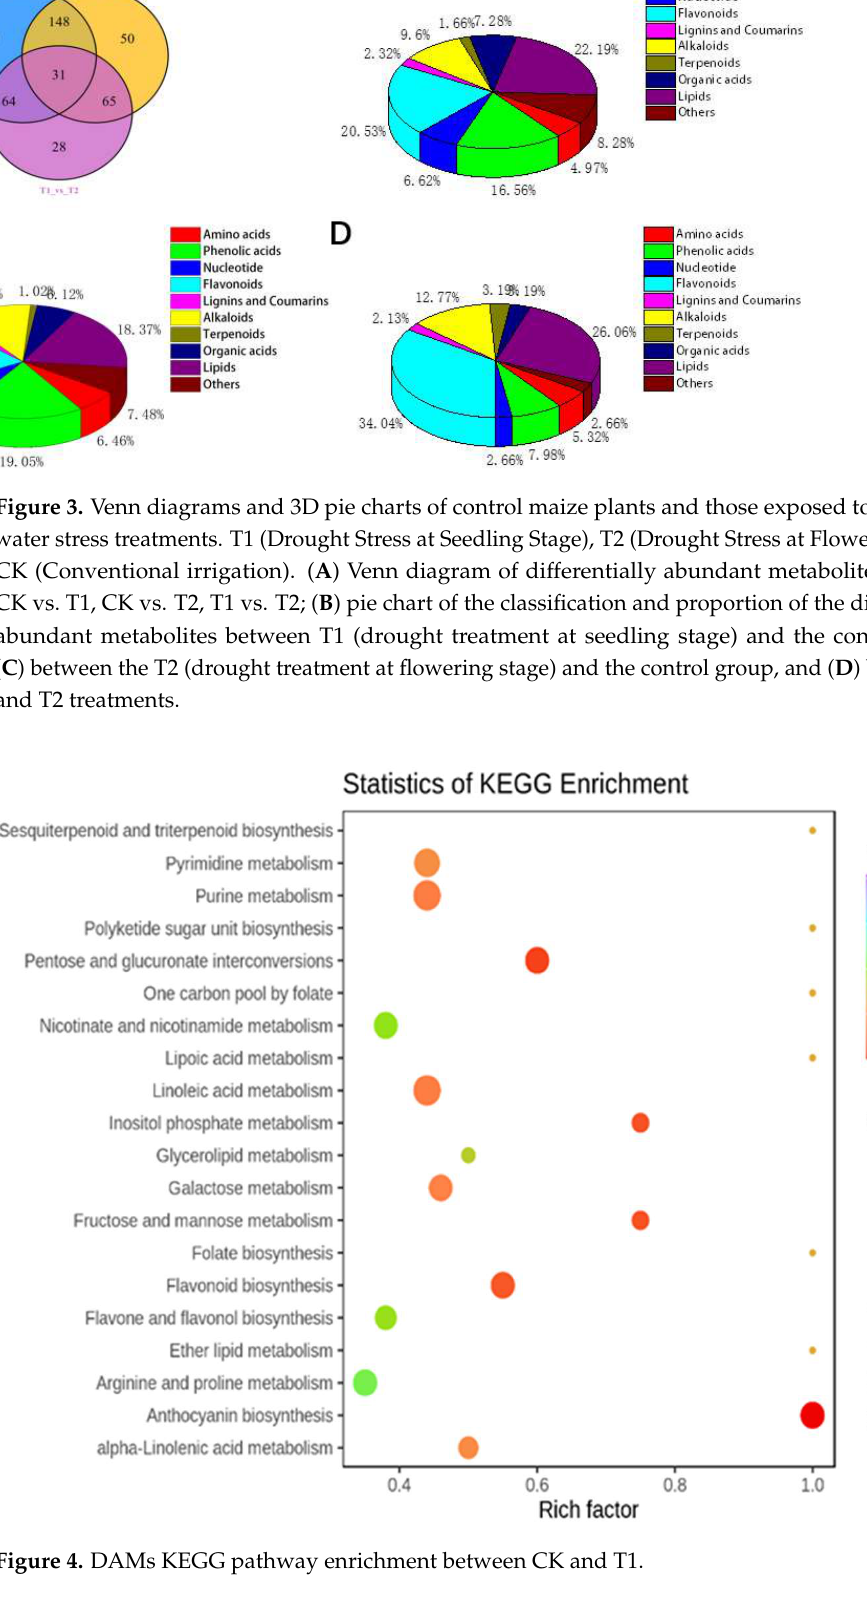
Figure 5. DAMs KEGG pathway enrichment between CK and T2.